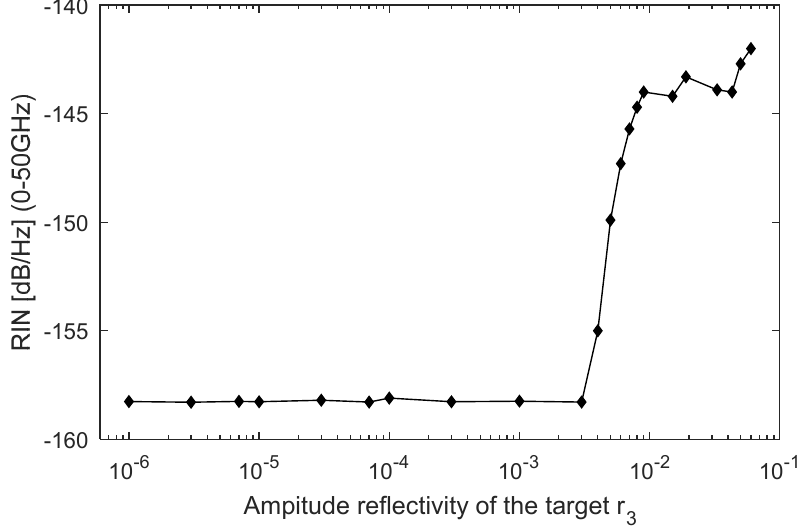
Figure 4. Relative intensity noise of a laser diode with EOF with J = 1.2 J th, L = 25 cm.